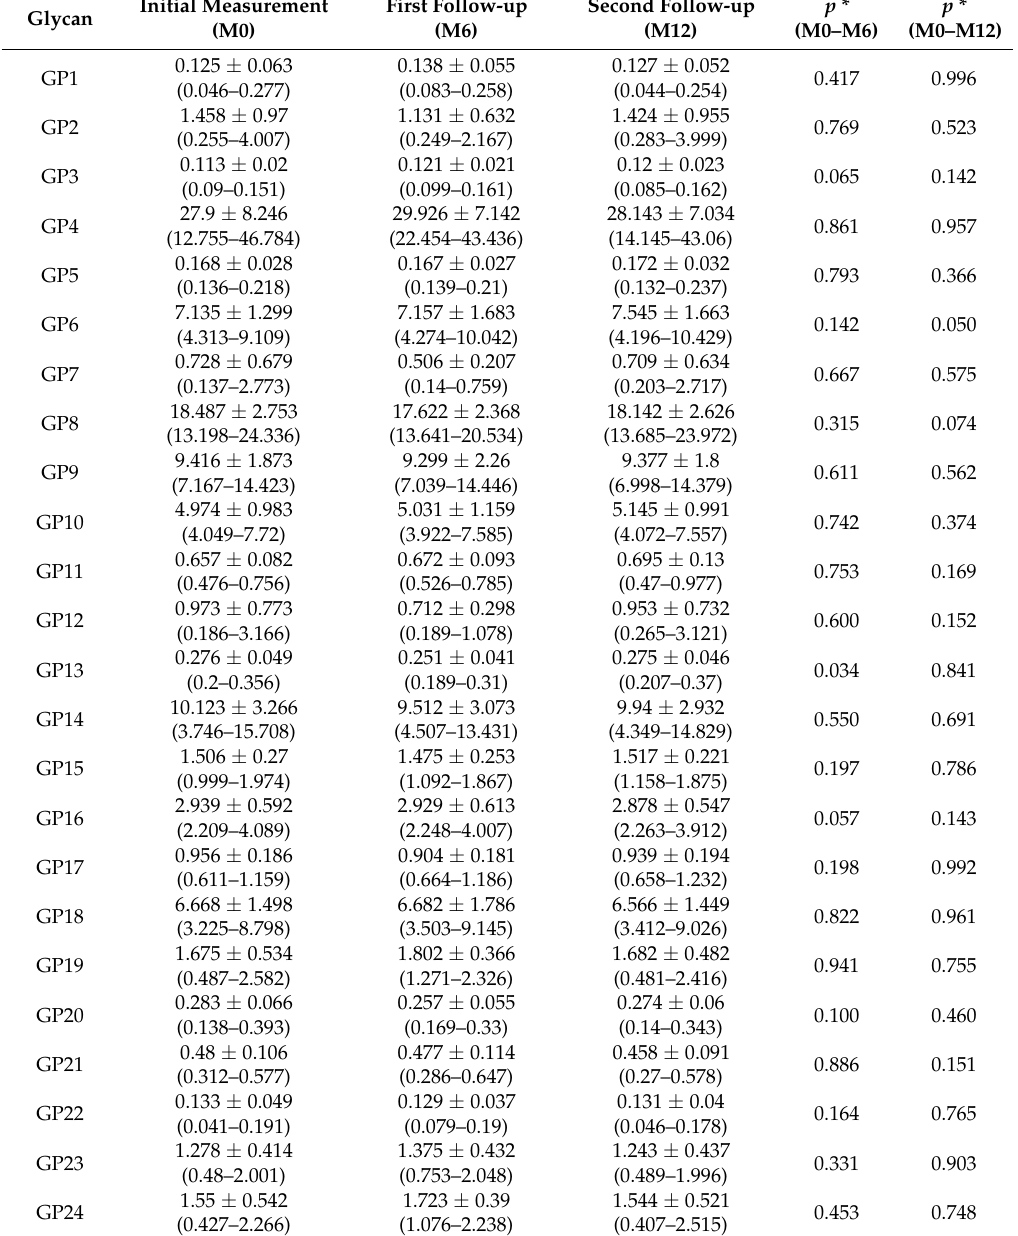
Table 2. Plasma glycan profiles of the initial measurements, first and second